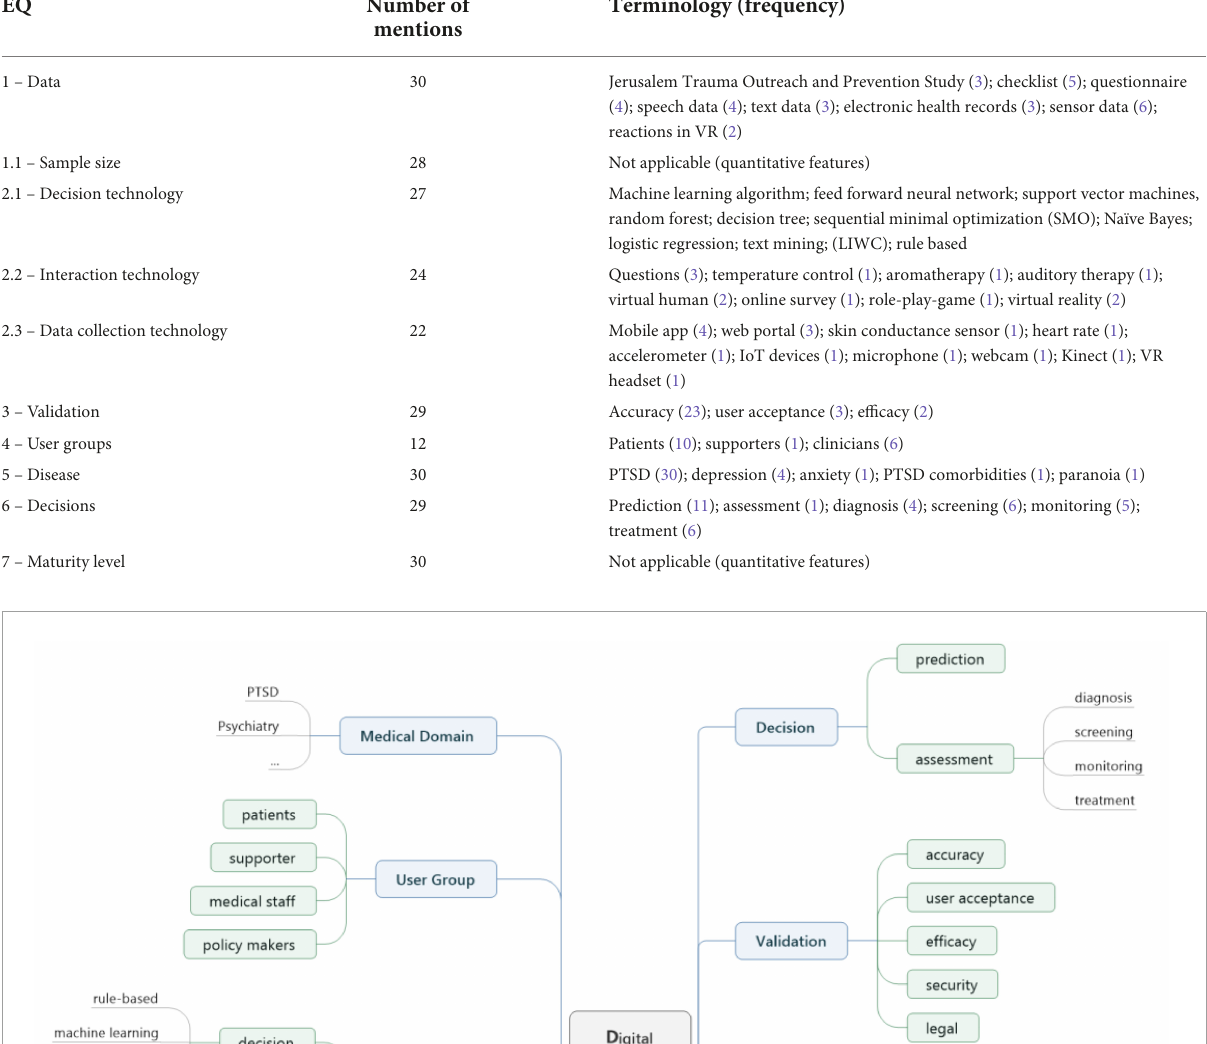
TABLE 4 Terminology extraction.